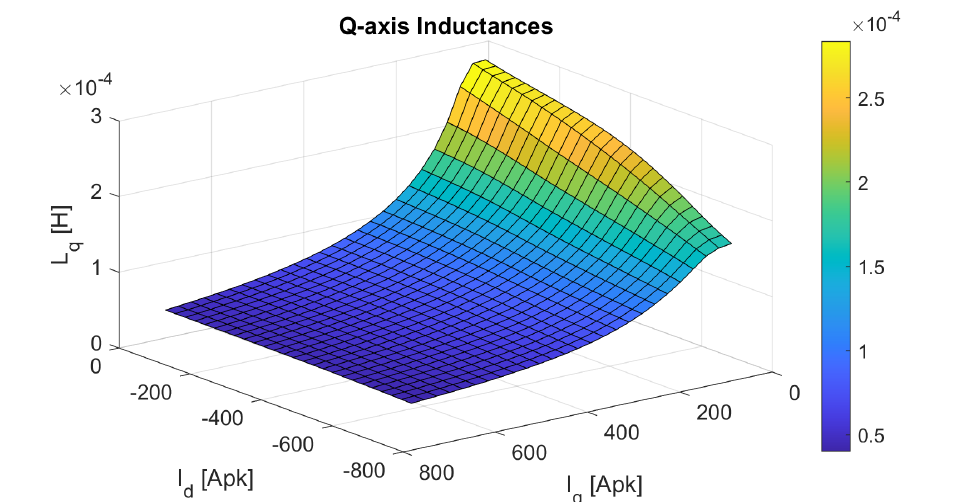
Figure 4. Inductance map of q -axis ( L q ) obtained with the Standard